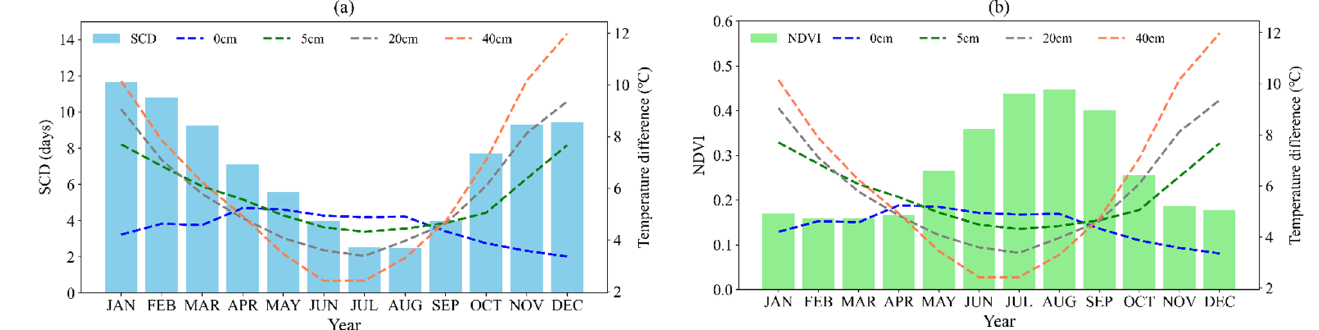
Figure 5. Multi-year average monthly SCD ( a ), NDVI ( b ) and temperature difference between atmosphere and soil from 0 cm to 40 cm.